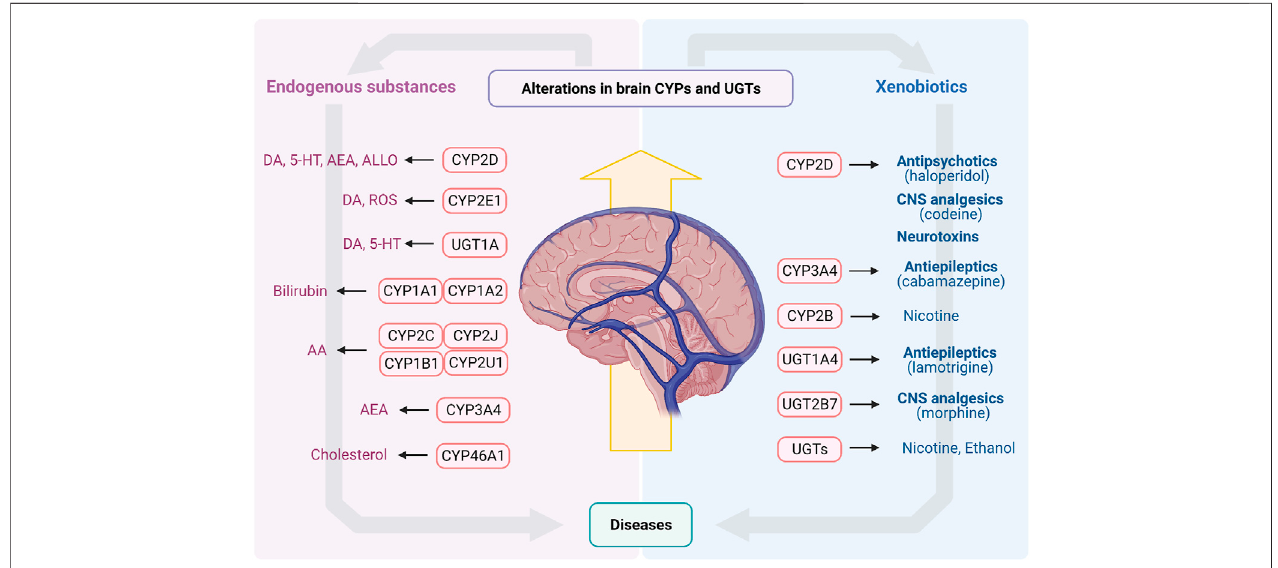
FIGURE 3 | The endogenous substances and xenobiotics metabolized by CYPs and UGTs in brain. AA, arachidonic acid; AEA, arachidonoyl ethanolamine (anandamide); ALLO, allopregnanolone; CNS, central nervous system; CYPs, Cytochrome P450s; DA, dopamine; ROS, reactive oxygen species; UGTs, UDP- glucuronosyltransferases; 5-HT,